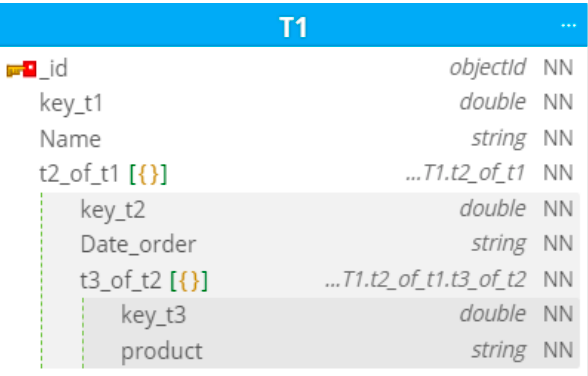
Figure 9. New collection with two levels of embedded documents.